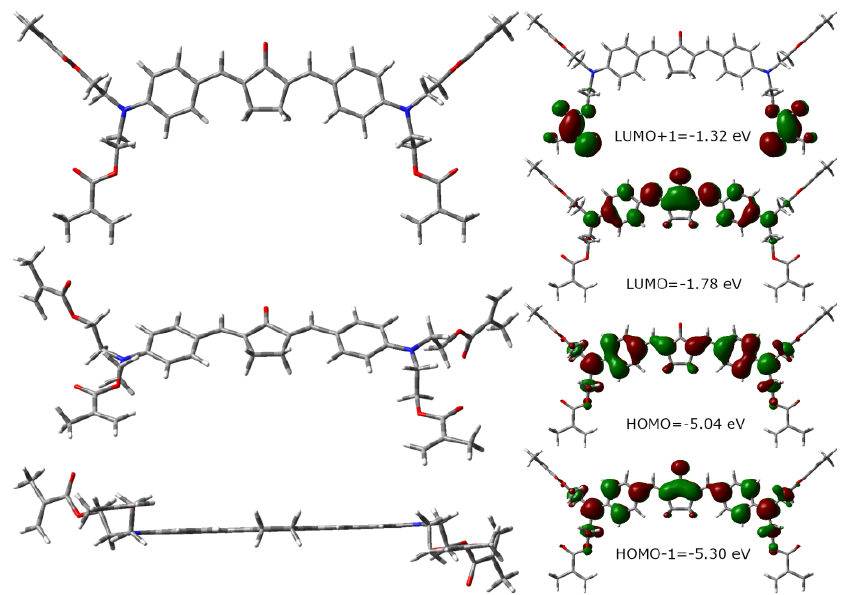
Figure 5. Optimized structure and molecular orbitals of 4Met-BAC. The HOMO and HOMO- 1 orbitals have π symmetry, with the electrons distributed through the whole conjugated π system. The HOMO π electron shows an interruption of the conjugation at the carbonyl group. LUMO level is mainly located at carbonyl and cy- clopentanone groups. These electron density distributions indicate that HOMO ⇒ LUMO transitions comprise intermolecular charge transfer. 3.1.4. Triplet State Investigation Laser flash photolysis experiments were conducted with 4Met-BAC in different sol- vents. In all cases, triplet – triplet absorption spectra include photobleaching of the singlet state, with position corresponding to the singlet absorption spectra. Longer wavelength regions demonstrate triplet absorption that gradually intensifies with the increasing wavelength (Figure 6a,b). In order to estimate triplet generation efficiency in every solvent, 4Met-BAC solu- tions with equal optical density at the excitation wavelength were prepared. Obtained triplet absorption maxima were compared in toluene, acetonitrile, and propanol-1. Triplet state generation ability is the most prominent in acetonitrile, closely followed by toluene; in the case of propanol-1 it is around 2.5 times less compared to acetonitrile. These results agree with the triplet state quantum yield determination experiments for MBAC deriva- tives [31]. The presence of carbonyl groups introduces exc ited (n, π*) terms into energetic level systems of molecules. The El-Sayed rule states [32] that intersystem crossing rate between excited states of different types exceeds that of the same type of excited states. Excited state energy level position depends on the solvent. For the similar ketocyanine dye, it was determined that the 1 (π, π*) energy level lies above both 3 (n, π*) and 3 CT energy levels in nonpolar solvents (cyclohexane, toluene). In the case of polar solvents, 1 (π, π*) lies above 3 CT but below the 3 (n, π*) energy level [25,31].